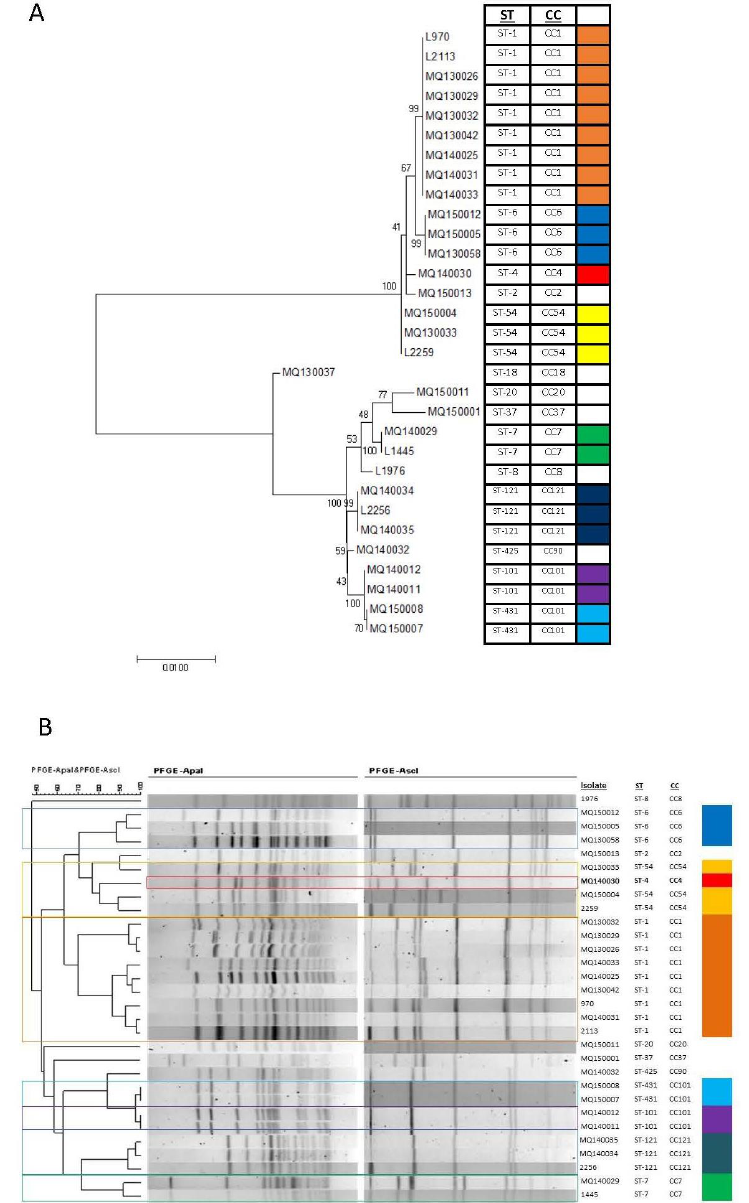
Figure 1. ( A ) Clustering of isolates based upon multi-locus sequence typing (MLST). The evolutionary history was inferred by using the Maximum Likelihood method based on the Tamura 3-parameter model [30] as outlined in detail in Materials and Methods. The tree with the highest log likelihood ( − 5971.3729) is shown. The percentage of trees in which the associated taxa clustered together is shown next to the branches. The tree is drawn to scale, with branch lengths measured in the number of substitutions per site. Evolutionary analyses were conducted in MEGA7 [31]; ( B ) Clustering of isolates based upon pulsed field gel electrophoresis (PFGE). Dendograms were generated with BioNumerics v7.0 software (Applied Maths) using UPGMA (unweighted pair group method with averages) and the Pearson coefficient with 1% tolerance. Using either method (MLST or PFGE) strains cluster into two distinct groups dependent upon lineage. ST: sequence type; CC: clonal